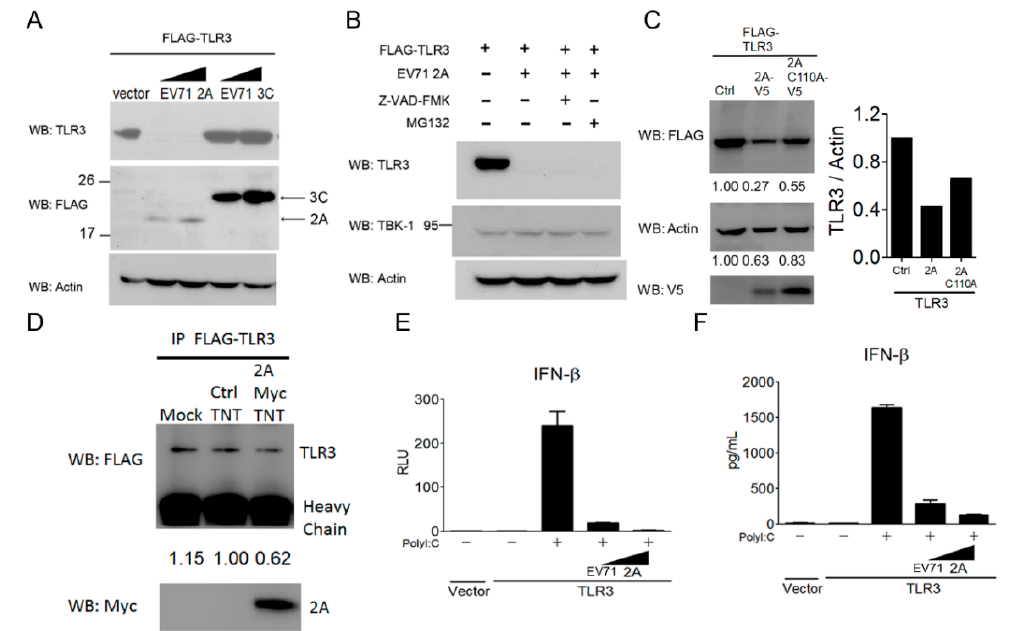
Figure 6. EV-A71 protease 2A targets TLR3 to inhibit type I IFN induction. ( A ) HEK293 cells were transfected with Flag-tagged TLR3 alone or together with increasing amounts of either Flag-tagged EV-A71 2A or Flag-tagged EV-A71 3C. After 20 h, the transfected cells were harvested for the Western blot analysis using the indicated antibodies. ( B ) HEK293 cells were transfected with Flag-tagged TLR3 alone or together with Flag-tagged EV-A71 2A. After 4 h, the transfected cells were treated with a pan-caspase inhibitor Z-VAD-FMK (100 µ M) or a proteasome inhibitor MG132 (20 µ M). After another 16 h, the treated cells were harvested for the Western blot analysis using the indicated antibodies. ( C ) HEK293 cells were transfected with Flag-tagged TLR3 alone or together with V5-tagged EV-A71 2A or V5-tagged EV-A71 2A C110A. After 48 h, the transfected cells were harvested for the Western blot analysis using the indicated antibodies. ( D ) 293T cells were transfected with FLAG-TLR3. Cell lysates were subjected to the immunoprecipitation and incubated with purified EV-A71 2A protease at 37 ◦ C for 4 h; treated cell lysates were then subjected to Western blotting. ( E , F ) HEK293 cells were transfected with an IFN- β luciferase reporter together with Flag-tagged TLR3 only or with increasing amounts of Flag-tagged EV-A71 2A. After 24 h, the transfected cells were left untreated or were treated with poly(I:C) (50 µ g/ml). After another 20 h, the treated cells were harvested to analyze the IFN- β promoter activity using luciferase assays ( D ) or IFN- β cytokine production using ELISA ( E ). Data are representative of at least two or three independent experiments.